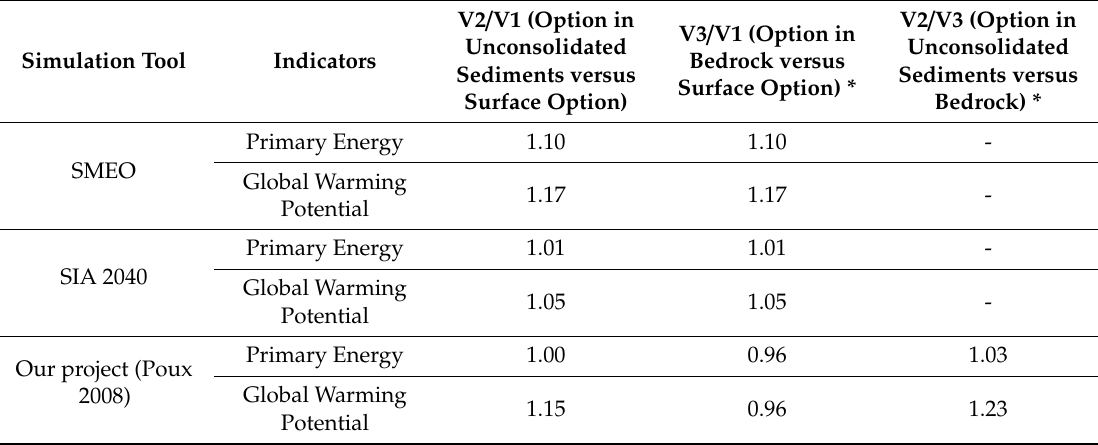
Table 3. SMEO and SIA 2040 ready-available simulation tools for the Swiss market do not account for the di ff erences in geological conditions. Nevertheless, the cost comparisons do not reveal any major upcharge in lifecycle costs between surface and subsurface